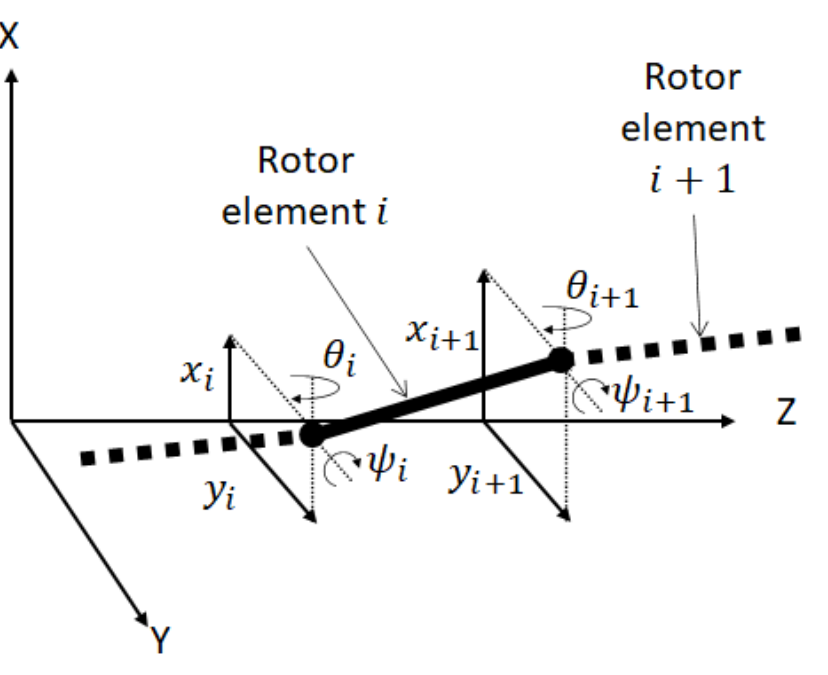
Figure 3. Finite element coordinate